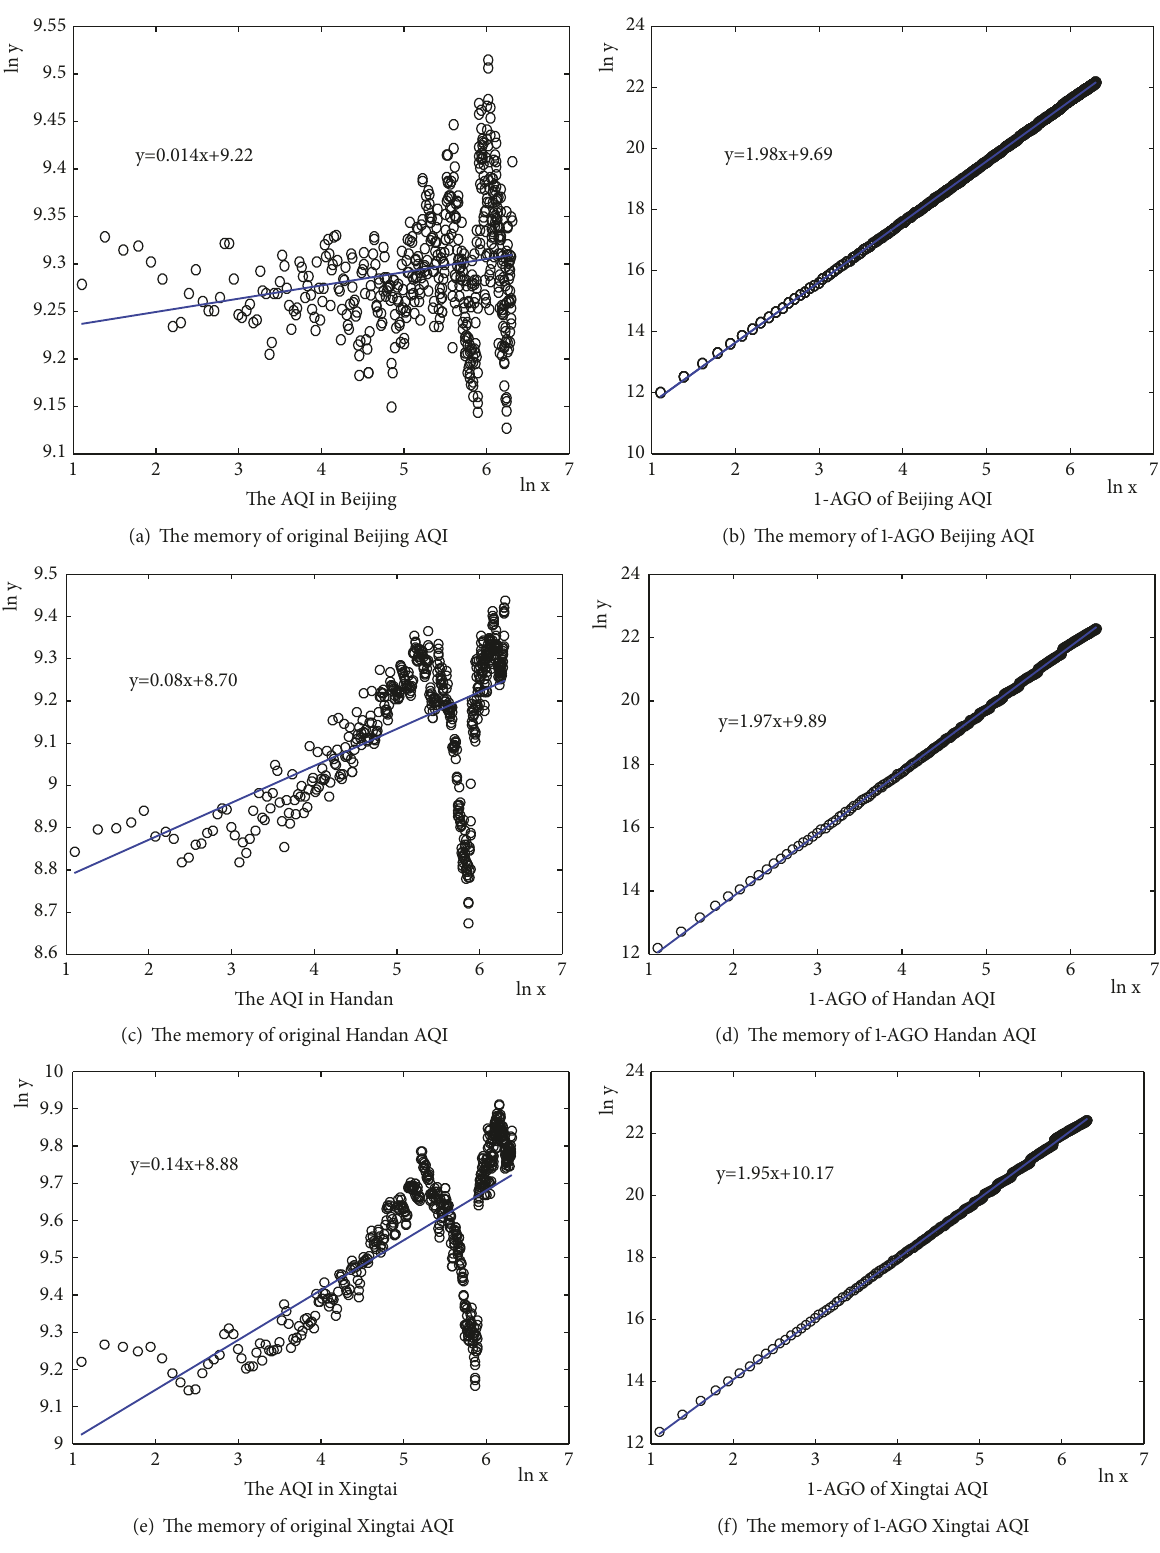
Figure 4: The memory of original AQI value and one-order accumulation value of three